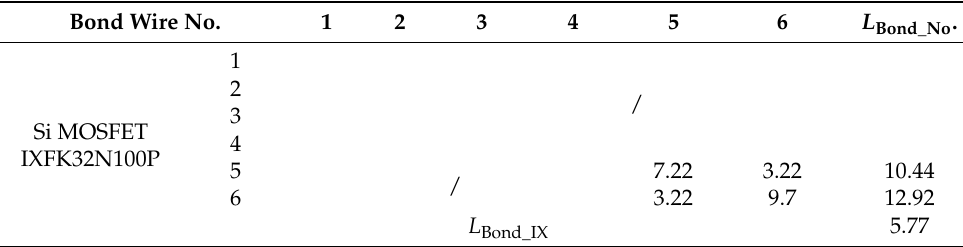
Table A3. Parasitic inductance, L Bond , with four bond wire cutoffs. Bond Wire No.